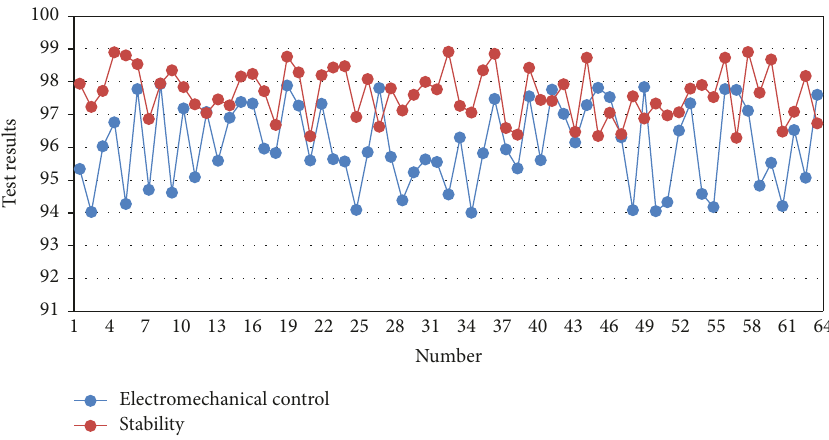
Figure 9: Verification of the effect of the electromechanical control system based on computer fault-tolerant